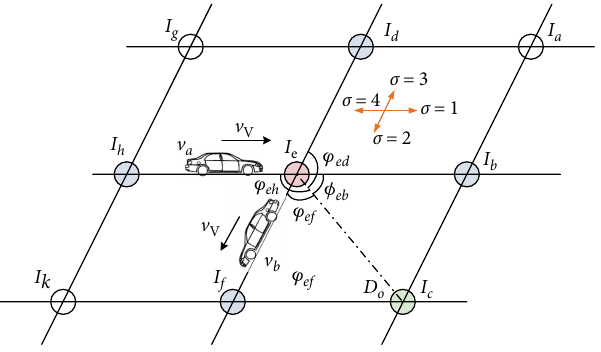
Figure 3: Packet forwarding at intersections.